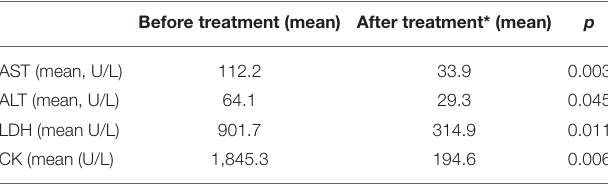
TABLE 2 | Laboratory results for AST, ALT, LDH and CK before and after treatment in 26 JDM patients with anti-NXP2 autoantibodies. Before treatment (mean) After treatment*